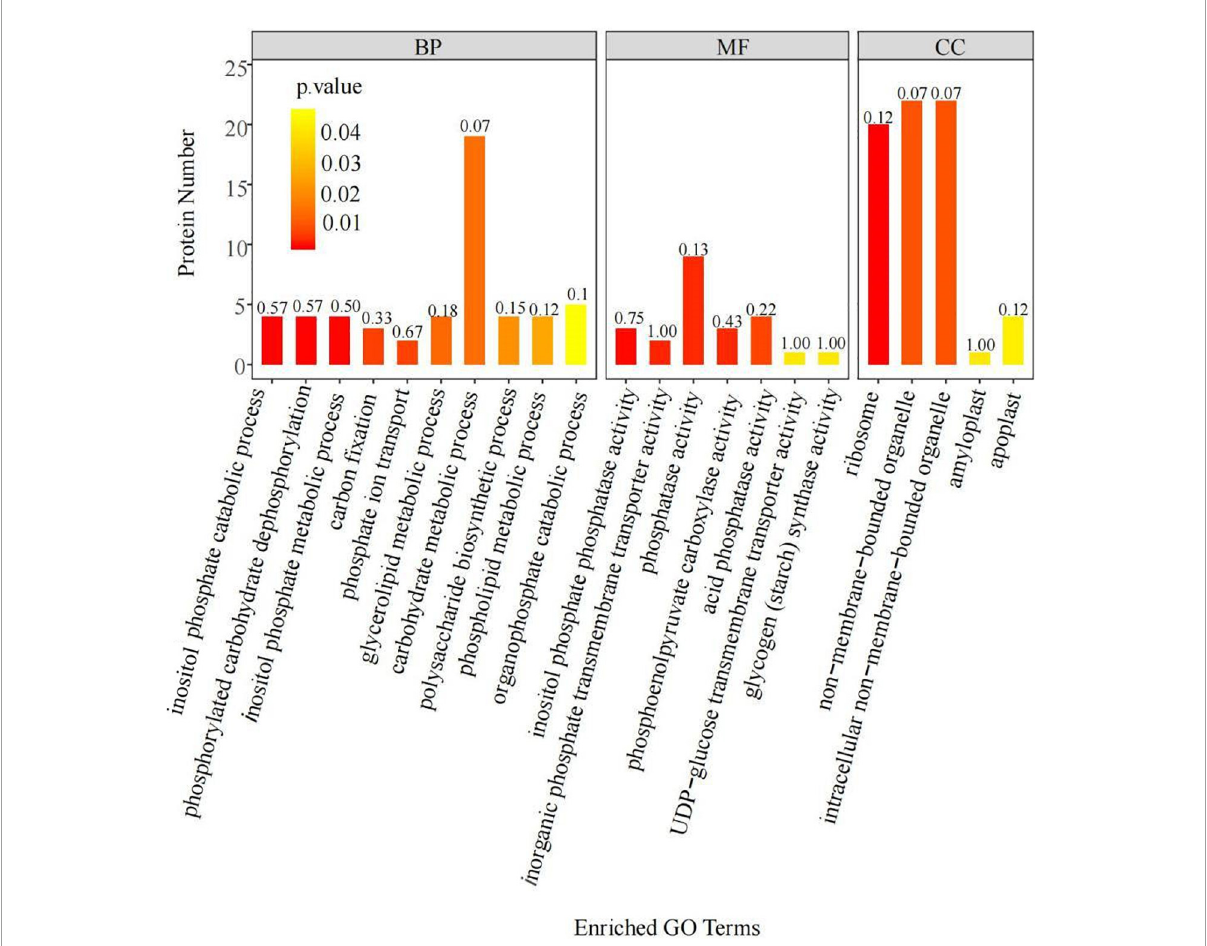
FIGURE1 Gene Ontology (GO) annotation statistics of the differentially expressed proteins (DEPs) in soybean roots. The − log10 P -value, for each annotation.